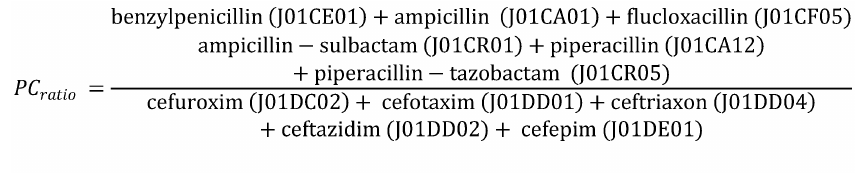
Figure 1: Formula of the penicillin-cephalosporin ratio (PC ratio) calculated referring to pharmacy dispensing data in g/100 inpatient